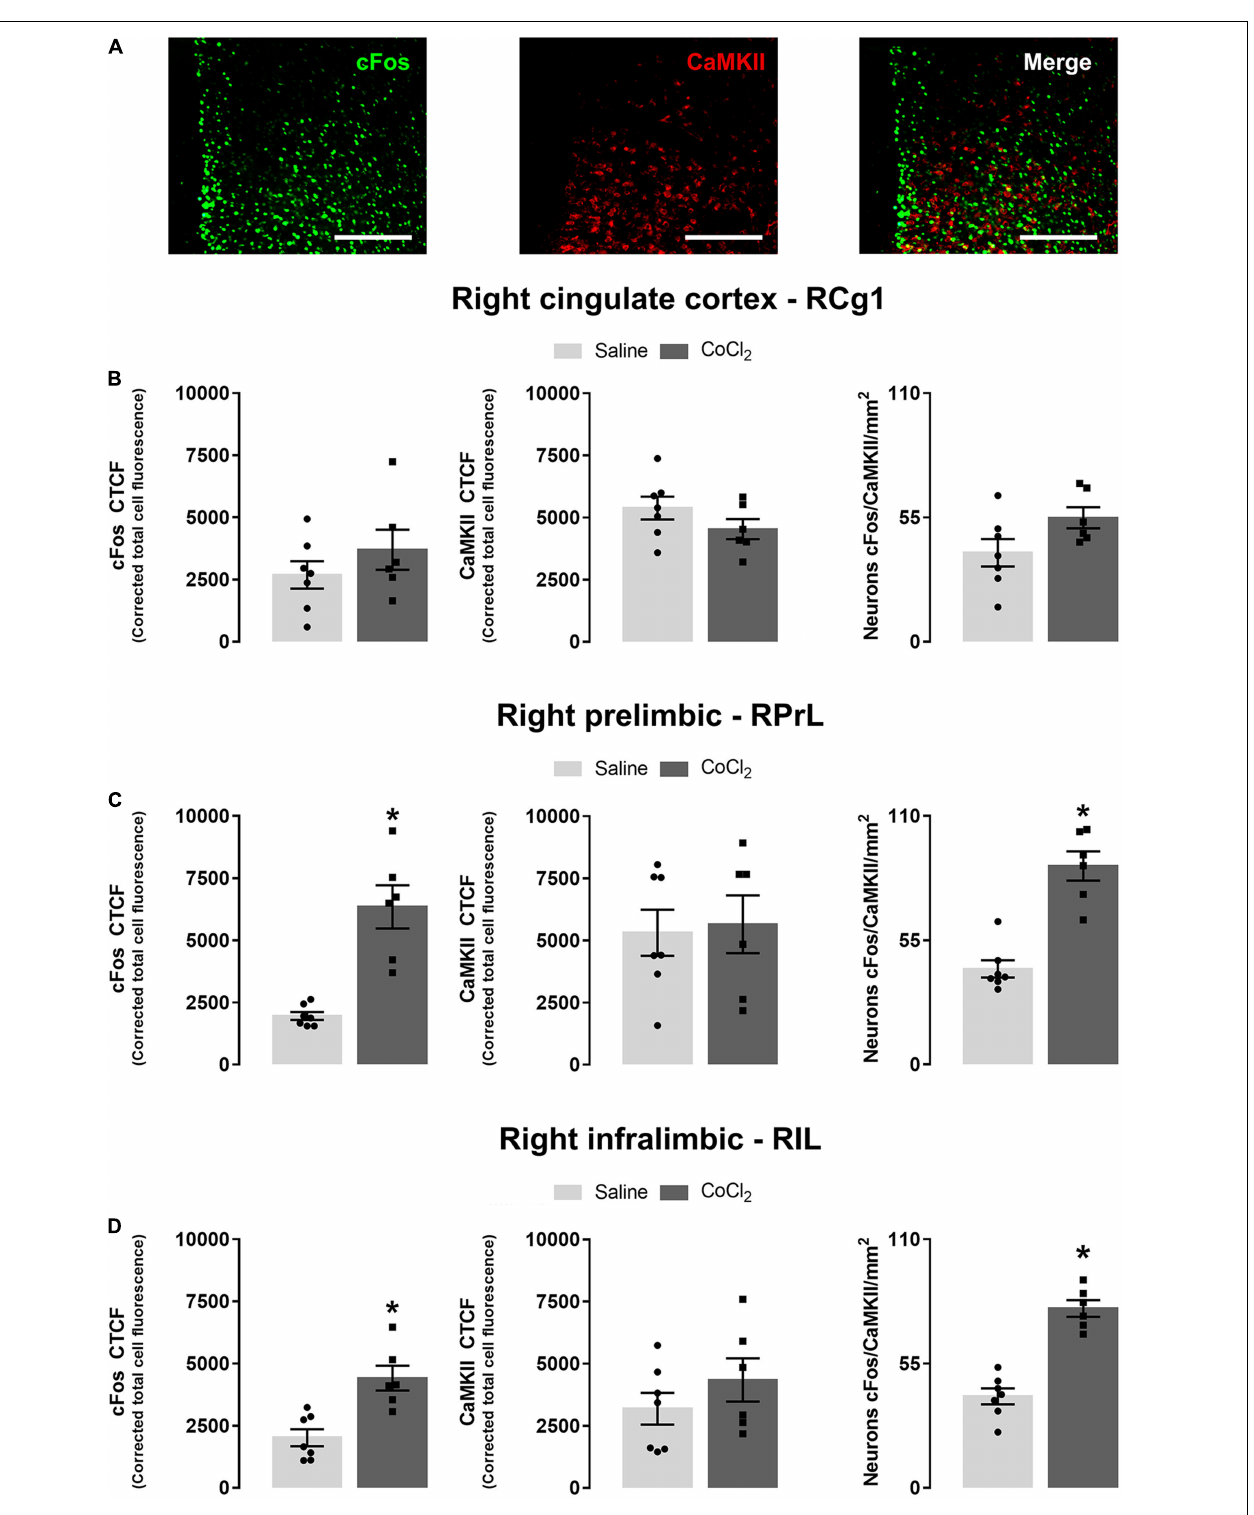
FIGURE 5 | Anxiogenesis induced by left PrL inhibition (with local injection of CoCl 2 ) increases cFos and cFos + CaMKII labeling in the right PrL and IL (but not Cg1) subareas. (A) Representative × 20 images showing cFos, CaMKII, and double labeling for cFos and CaMKII on the right mPFC (scale bar = 100 µ m). Corrected total cell fluorescence (CTCF) for cFos, CaMKII, and cFos + CaMKII-positive neurons in the RCg1 (B) , RPrL (C), and RIL (D) . Saline ( n = 7) and CoCl 2 ( n = 6). Bars with scatter dot plot represent mean ( ± SEM). * p < 0.05 compared with the saline group. CoCl 2 , cobalt chloride.